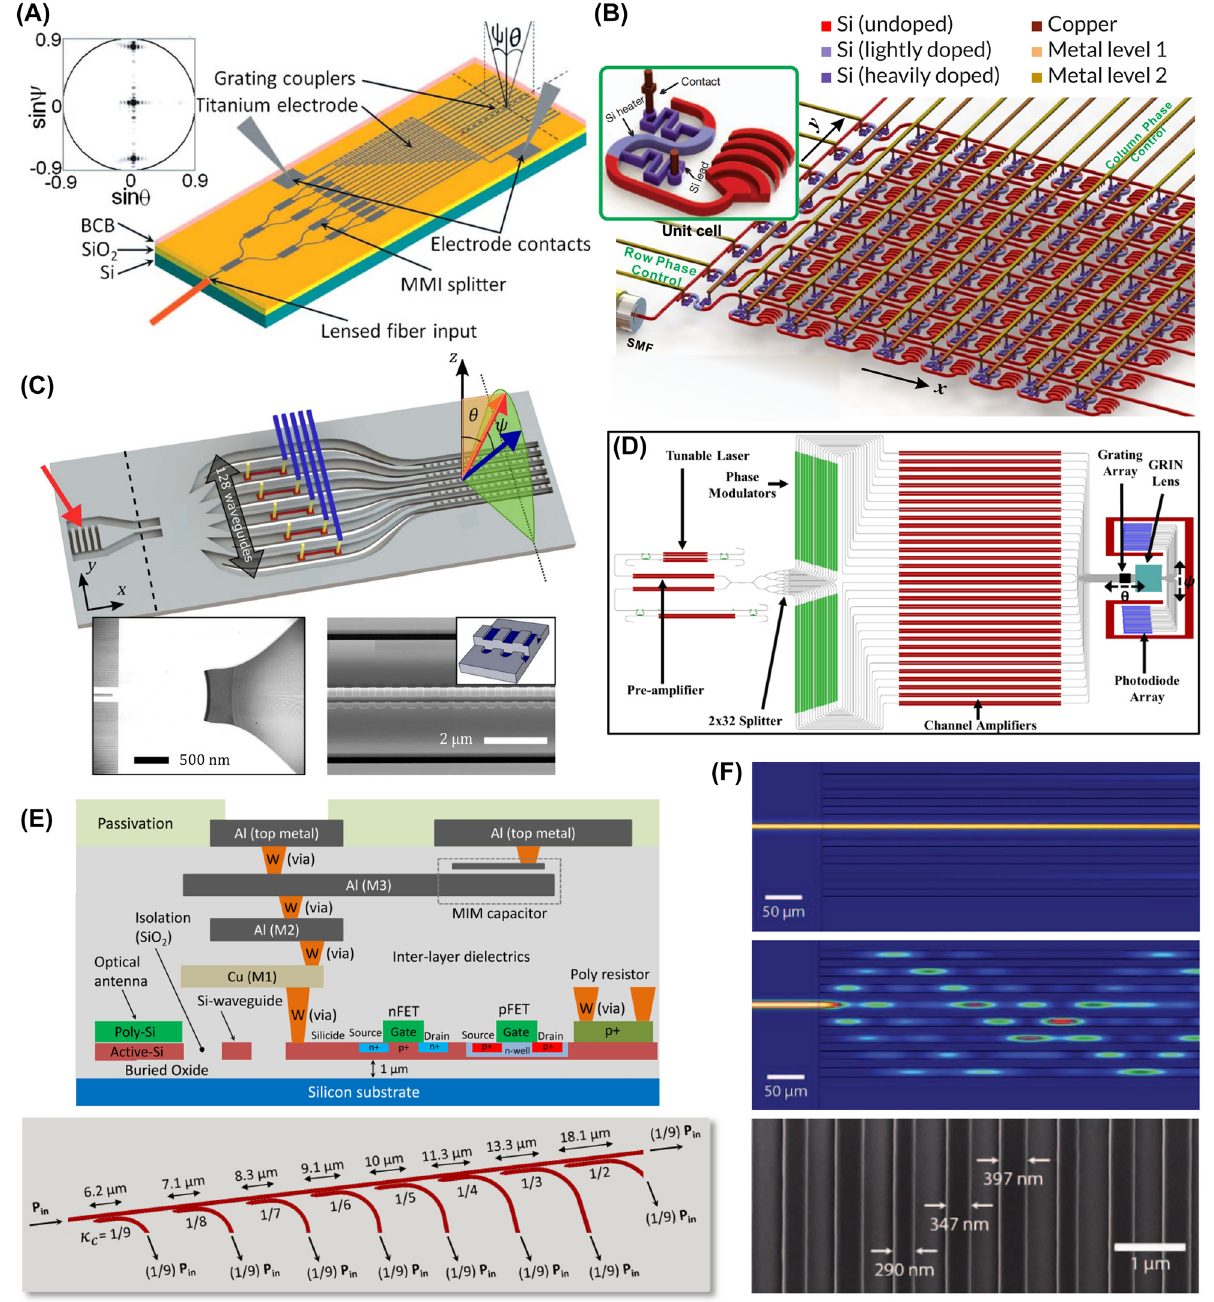
Figure 4: Optical phased